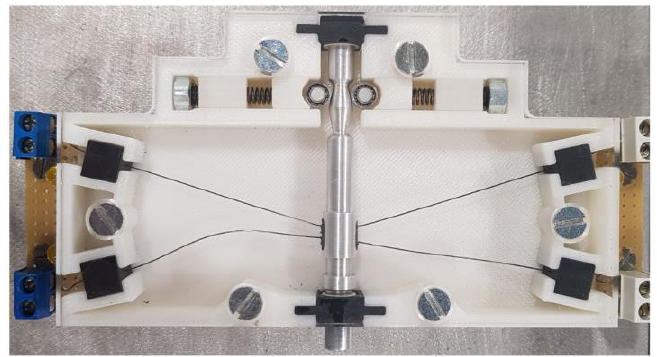
Figure 5. Locking device based on antagonistic SMA-wires